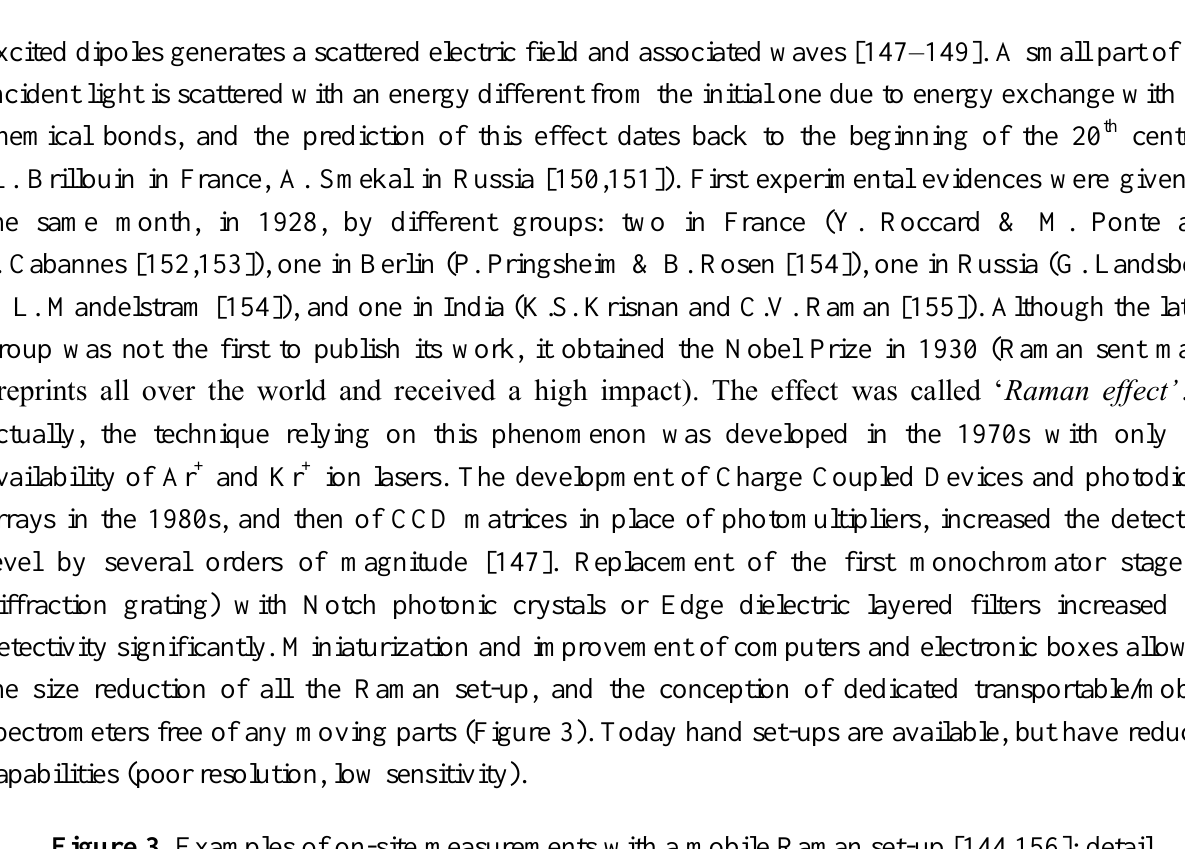
Figure 3. Examples of on-site measurements with a mobile Raman set-up [144,156]; detail about the positioning of the remote optical head is